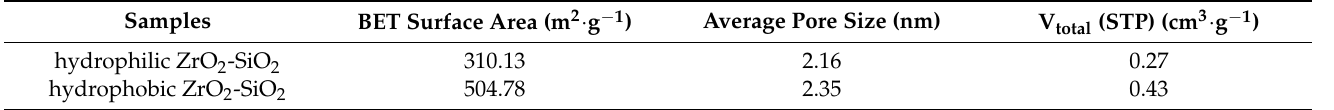
Table 1. Pore structure parameters of the hydrophilic and hydrophobic ZrO 2 -SiO 2 xerogels. Samples